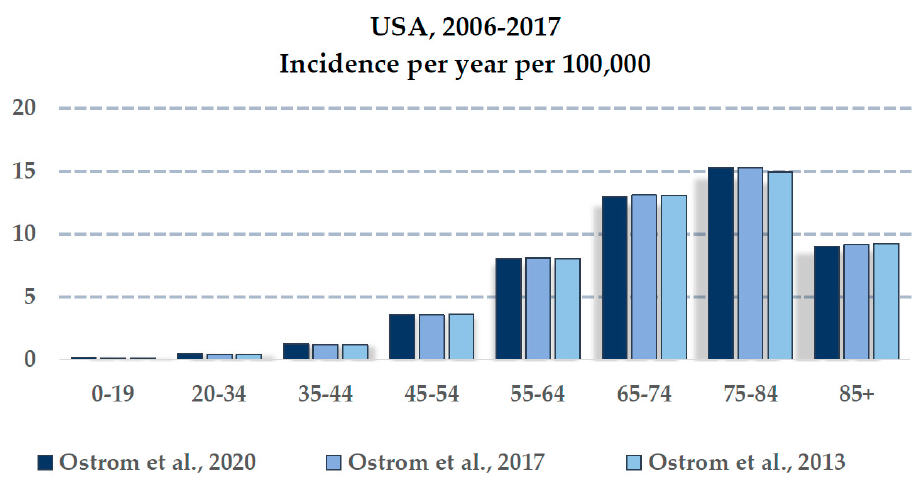
Figure 3. Age-related incidence of GBM (100,000/years) [14,100,101].